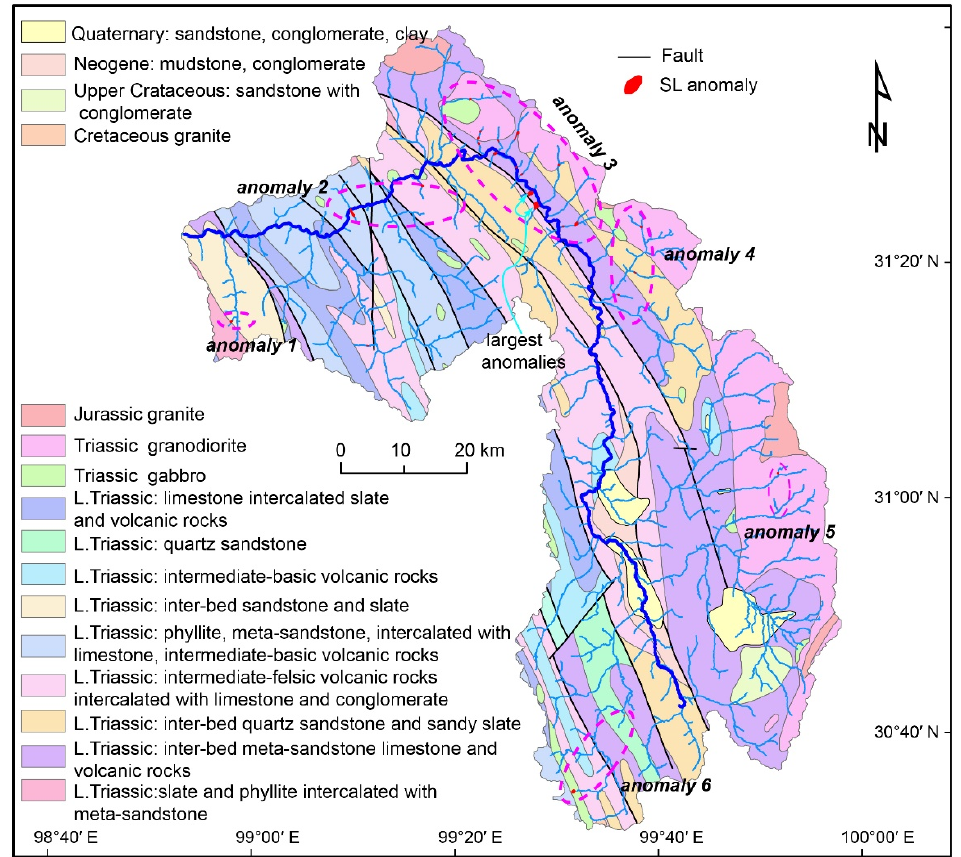
Figure 5. SL index anomalies and the catchment geology. The ellipses with magenta dashed line is significant SL index anomalous.